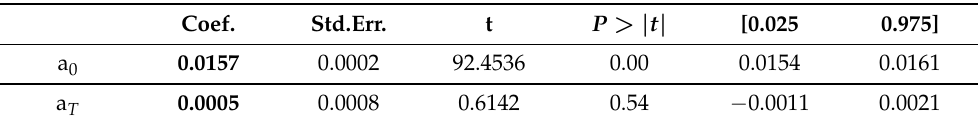
Table 4. Estimation of temperature dependent absorption parameters with measured data from 1950 to 2000.